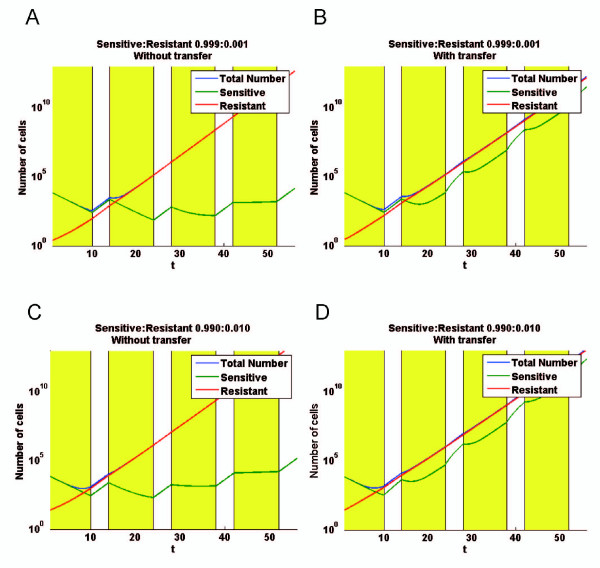
Computer simulation giving the consequences of cell-to-cell P-gp activity transfers in co-cultures exposed to doxorubicin, according to the mathematical model. A chemotherapy regimen is simulated by cyclic exposure of an inoculum of 104 cells to 1 μM doxorubicin. The treatment cycled every 14 days, with 10 days of doxorubicin treatment followed by 4 days of interruption, for 4 cycles. The initial proportions of resistant MCF-7/Doxo vary form 0,1% (A & B) to 1% (C & B). Simulations were performed in situations where transfers were abolished (A & C) or permitted (B & D) with the parameters determined in Figure 6. For each condition, the numbers of sensitive, resistant and total cells are plotted versus time. Sensitive MCF-7 are defined as cells having negative growth rate in the presence of 1 μM doxorubicin (see Figure 7).